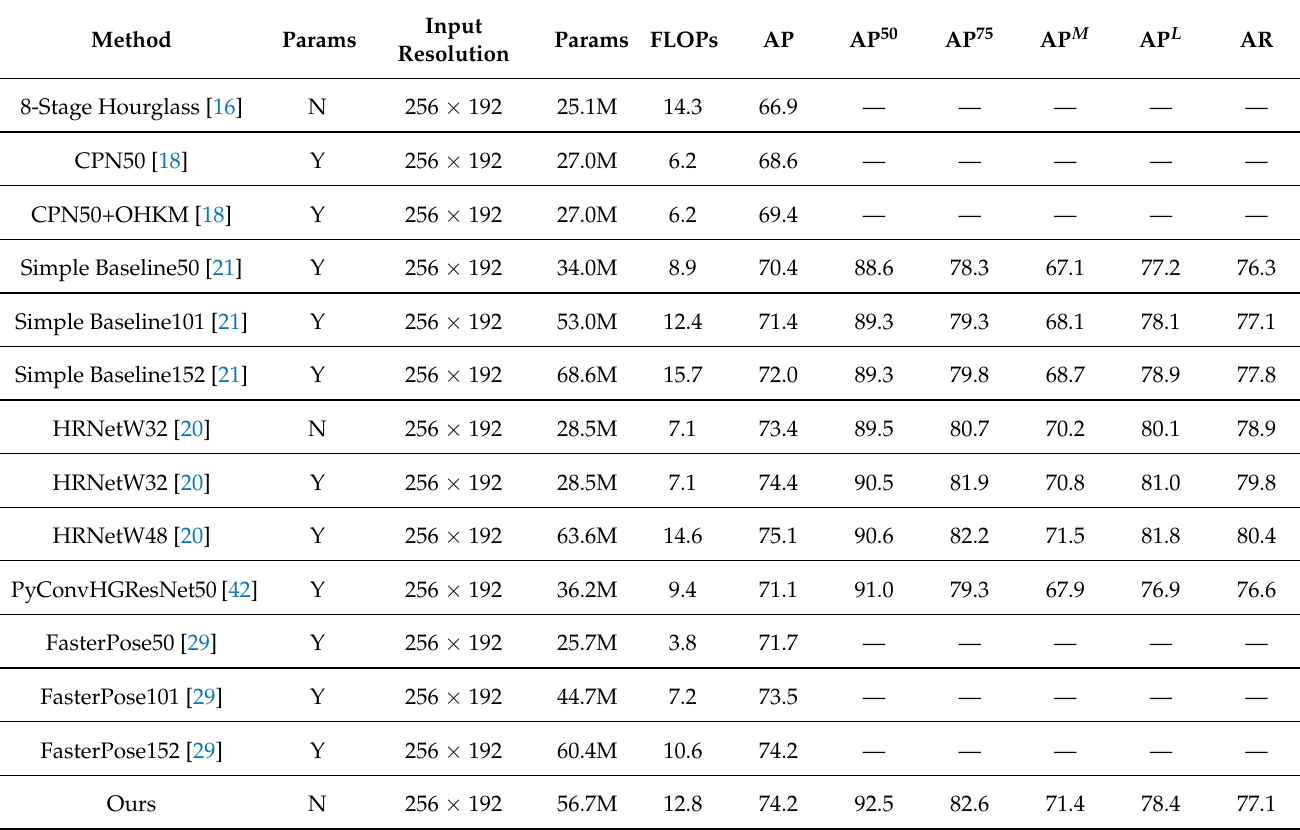
Table 3. Comparison results of different models on the COCO validation set.